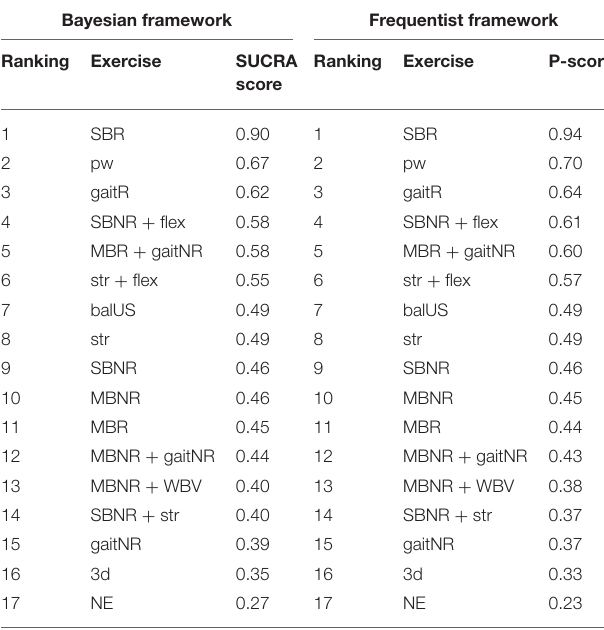
TABLE 4 | Ranking of exercise